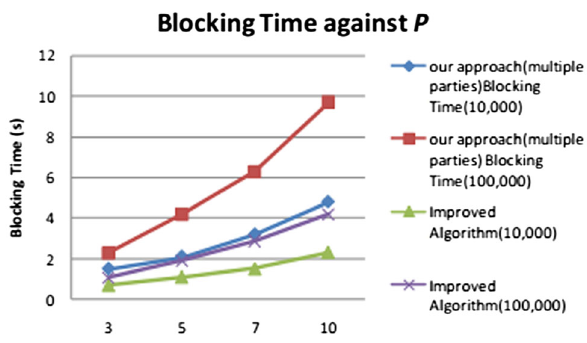
Fig. 13 Blocking Time with varying p for multi-part private